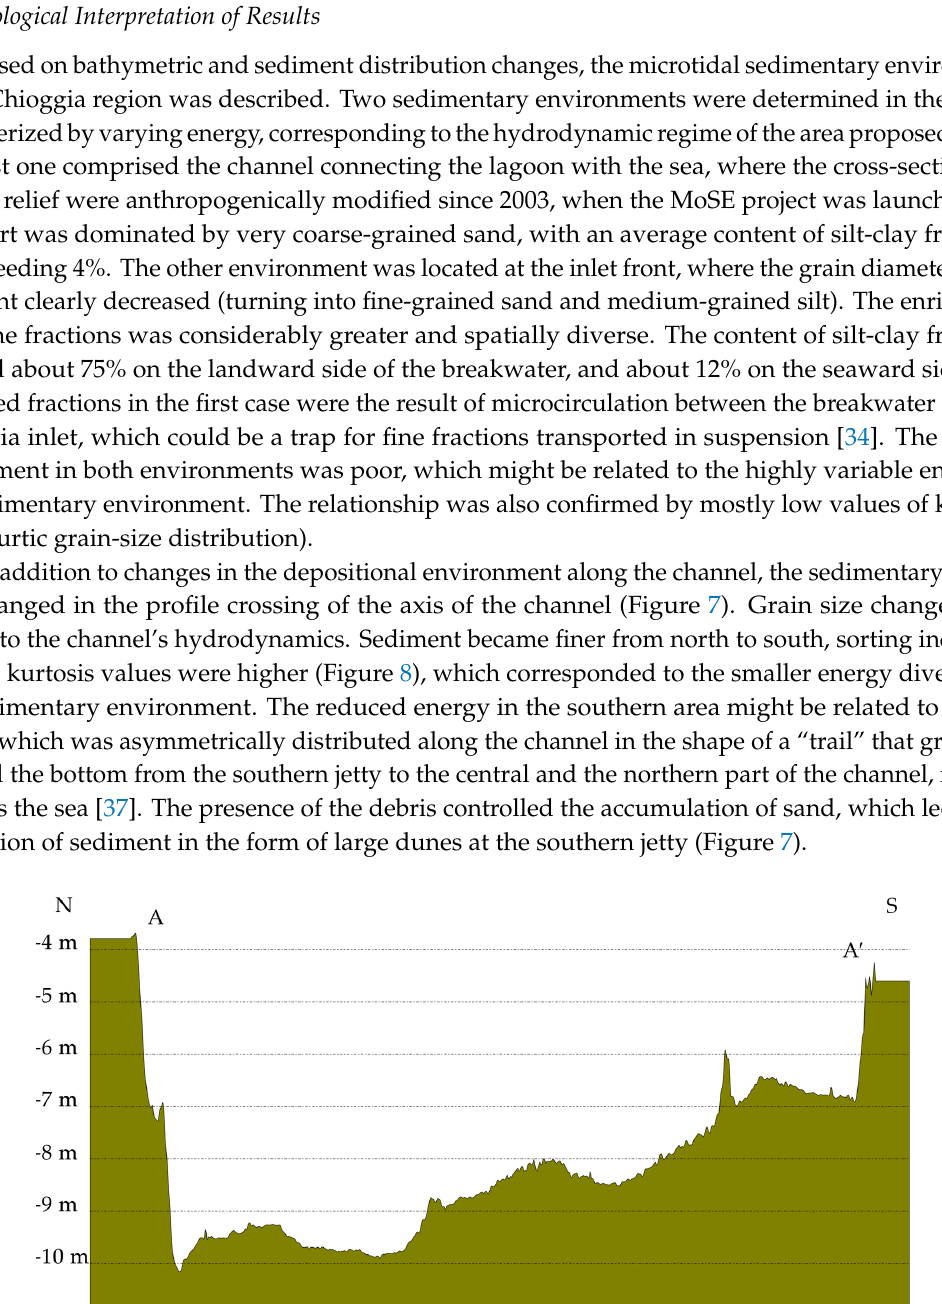
( a ) ( b ) Figure 8. Relationships between grain size parameters along the A-A’ profile. ( a ) Mean size vs. sorting; and ( b ) mean size vs. kurtosis. The human impact associated with the construction of the MoSE barriers in the Chioggia region had affected the hydrodynamic regime of the inlet. We observed activities such as reducing the width of the Chioggia inlet for the MoSE infrastructure, building rip-rap revetments on the channel bottom, and constructing a breakwater in front of inlet. These modified the length and direction of the outflow jet patterns of currents around the inlet [34,37], which was reflected in the morphological and sedimentary changes of this area. 4.3. Suggestions for Future Research The results presented in this work were produced using OBIA, assuming a supervised classification. Especially in terms of further change detection studies elsewhere, modern MBES calibrated for acoustic backscatter, potentially allow knowledge-based unsupervised classification after single ground truth identification of benthic habitats. It might be important especially because